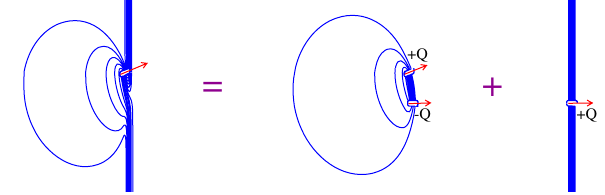
FIG. 4. Decomposition of the field of a bunch moving in a magnetic field (left plot) into two fields: a field of a dipole (middle plot) and a field of a bunch moving straight in the initial direction (right plot). Red arrows show directions of a bunch velocity.